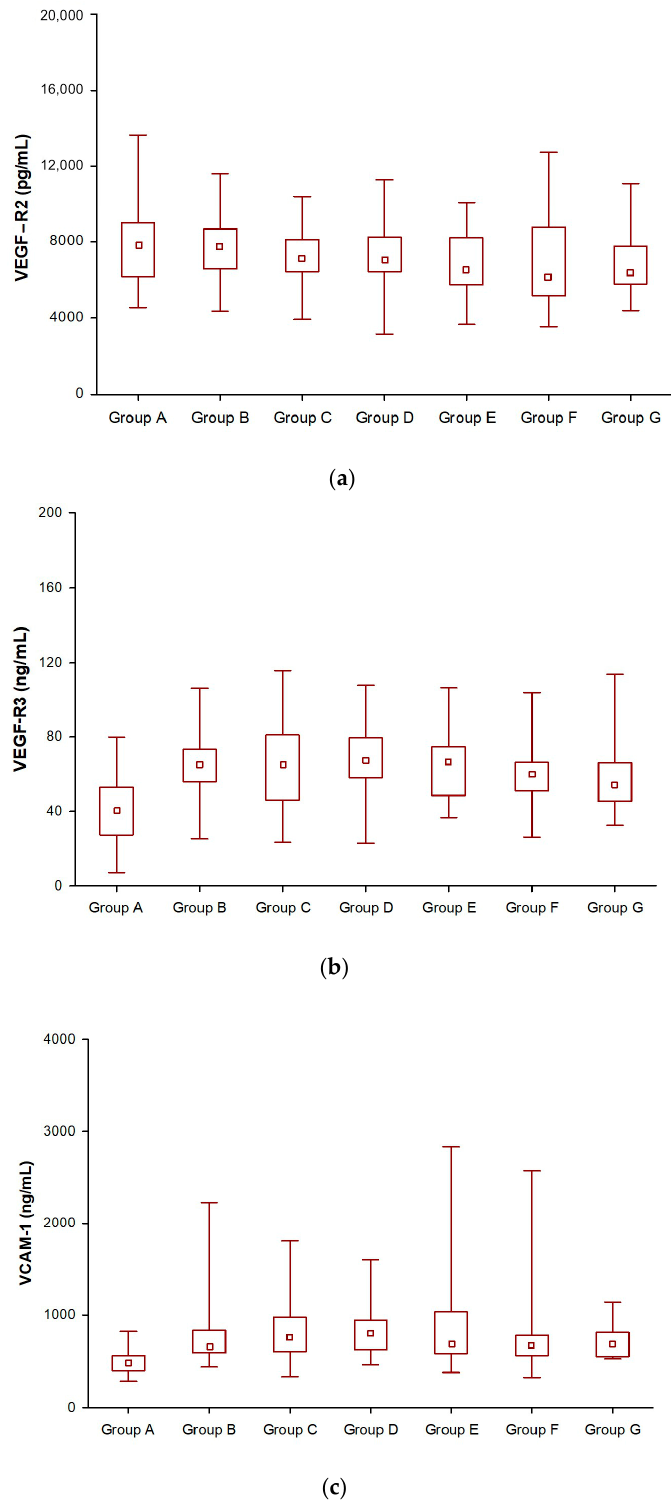
Figure 1. Changes in vascular endothelial growth factor receptor 2 (VEGF-R2) ( a ), vascular endothelial growth factor receptor 3 (VEGF-R3) ( b ), and vascular cell adhesion molecule-1 (VCAM-1) ( c ) levels during somatostatin analogue (SSAs) treatment in patients with neuroendocrine tumors. Moreover, regarding Spearman’s correlation assessment of the relationship between VEGF-R2, VEGF-R3, VCAM-1, and the duration of treatment (Table S2 in the supplemen- tary material), a negative, statistically significant correlation was shown between VEGF- R2 and the duration of treatment. With the increase in the treatment period, a decrease in VEGF-R2 levels was observed (Figure 2). Regarding Spearman’s correlation assessment of the relation of VEGF-R3 and VCAM-1 to the duration of treatment, it was also not sta- tistically significant (Figures S1 and S2 in the Supplementary Material).